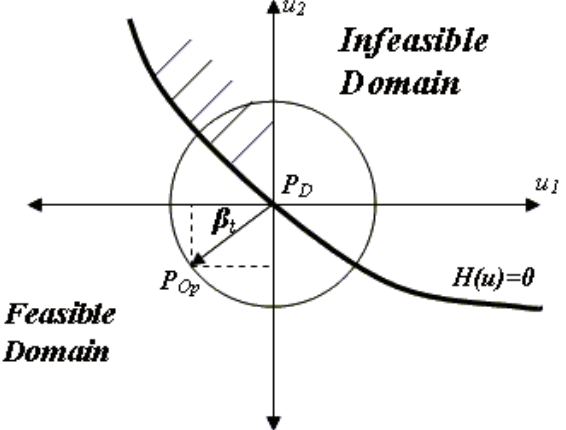
Fig. 3. Illustrated example for two-dimensional